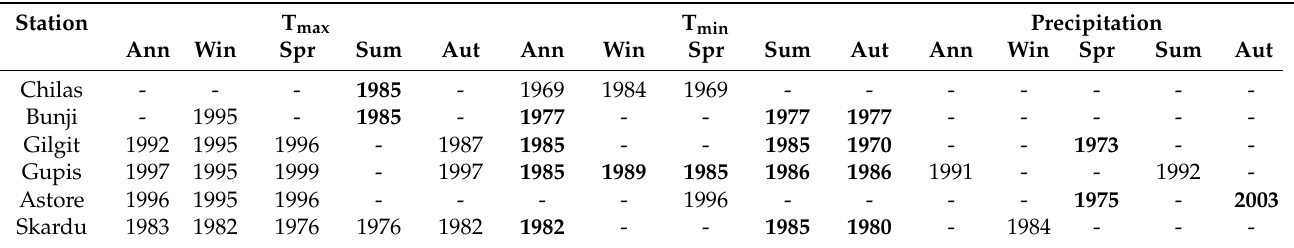
Table 6. Change point analysis in annual and seasonal T max , T min ( ◦ C/decade) and precipitation (mm/decade) during